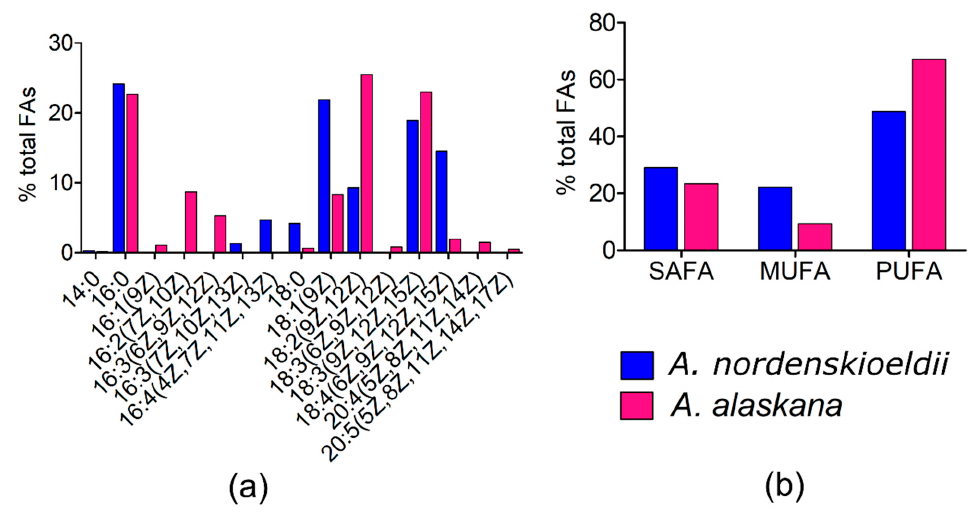
Figure 6. Cellular fatty acid composition Ancylonema nordenskioeldii (blue; WP211) and Ancylonema alaskana (pink; WP251). ( a ) The relative proportions of fatty acids in (%) of total fatty acids. (b ) The relative proportion of saturated (SAFA), monounsaturated (MUFA), and polyunsaturated (PUFA) fatty acids. The figure ( a ) shows only fatty acids that had abundances greater than 0.1% of total FAs.